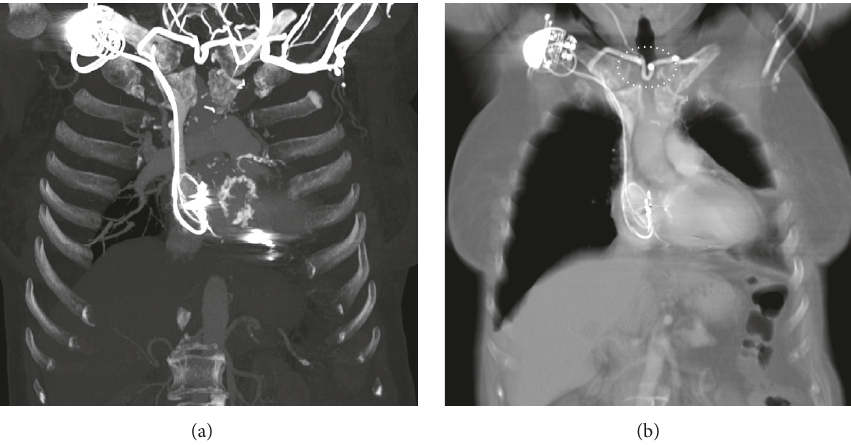
Figure 1: CT with administration of contrast media through a left peripheral vein. (a) Coronal maximum intensity projection image shows chronic occlusion of the left-sided central veins with cervical collateral veins from the left to the right side and here reaching the nonoccluded right-sidedcentralveins;slightmetalartifactsbytheright-sidedpacemaker.(b)Coronalmultiplanarreconstructionimageshowingapartially quite tortuous u-shape horizontal-transverse midline vein in the jugulum (dotted ellipse), the AJVS with the JVA.